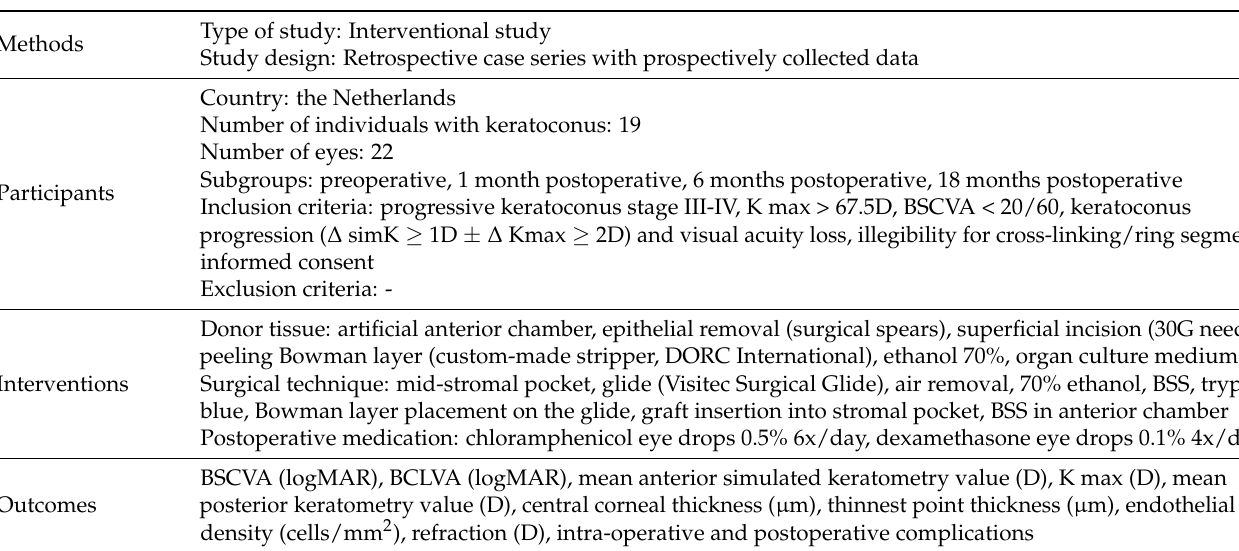
Table A19. Van Dijk 2015 [31].